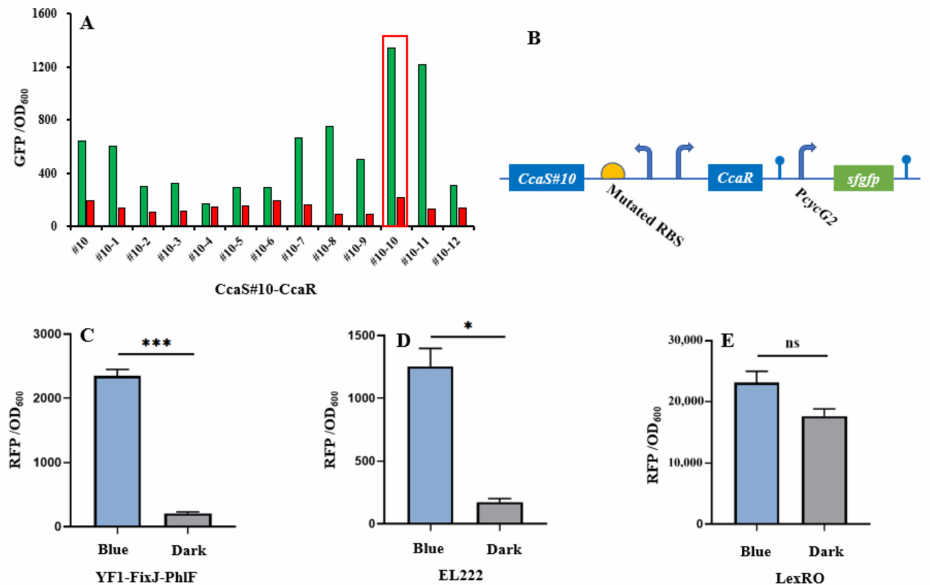
Figure 2. Characterization of light-trigged systems. ( A ) CcaS#10–CcaR system activated and re- pressed under green and red light, respectively. Strain #10 carrying CcaS#10–CcaR without RBS variants. Strains #10-1 to #10-12 containing variant RBS–CcaS#10–CcaR. ( B ) Light-sensing systems